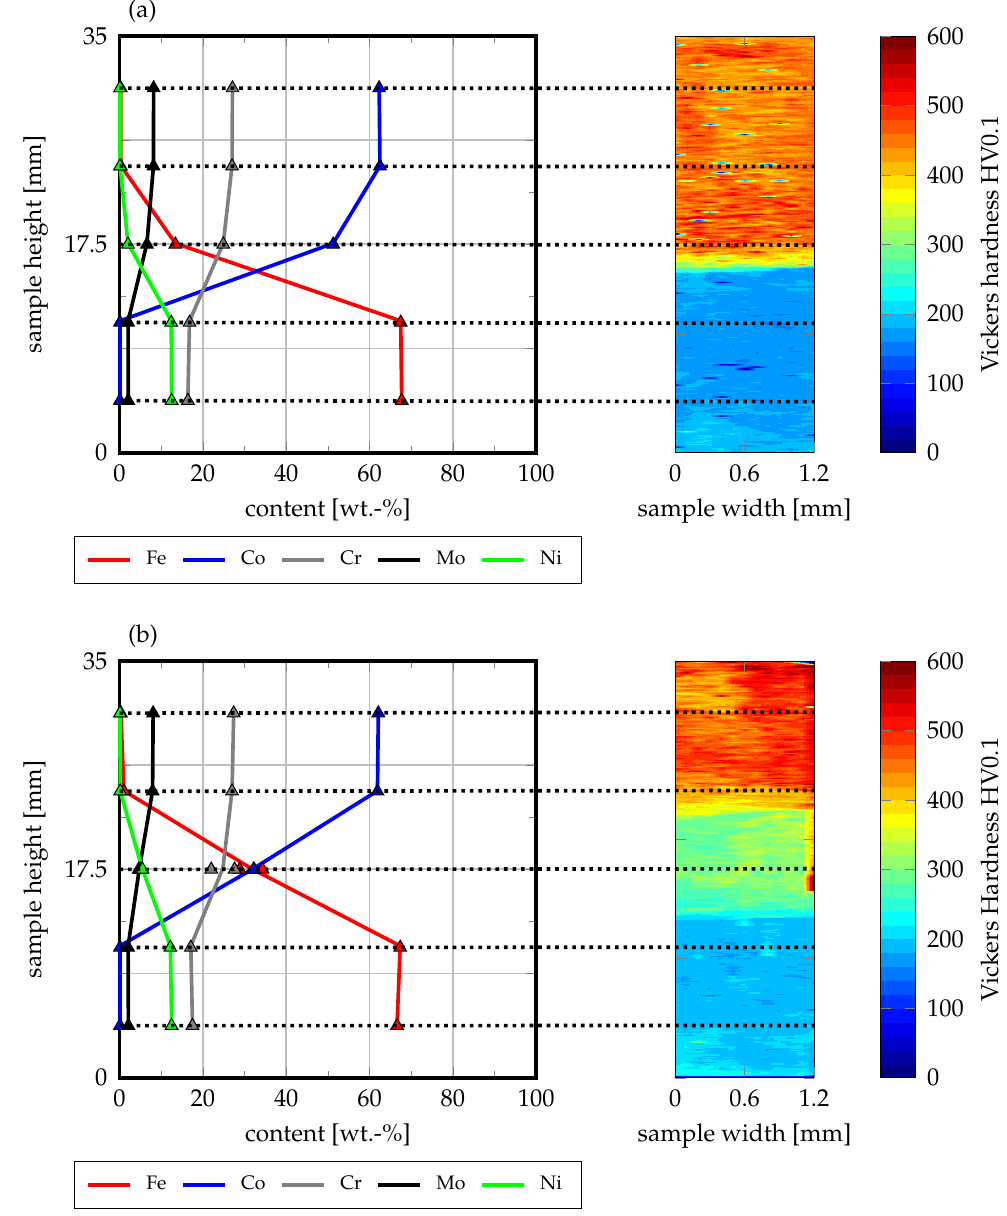
Figure 8. Correlation between chemical composition, analyzed by OES, and hardness distribution across the cross-section of AISI316L/CoCrMo multi-material structures. ( a ) sharp transition, ( b ) smooth